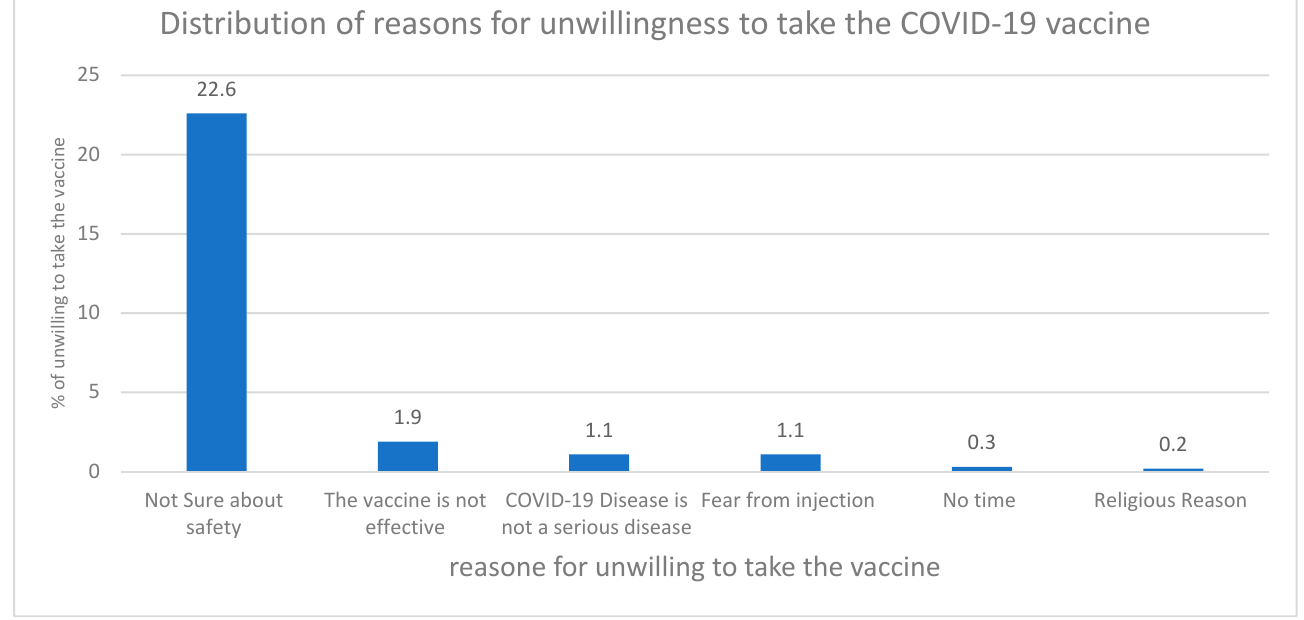
Figure 1. Distribution of reasons for unwillingness to take the COVID-19 vaccine. The multivariable analysis performed to investigate the significant factors of univariate analysis, after adjustment for sex, region, nationality, level of education, working state, and similar to the univariate. Table 4. Factors associated with an increased willingness to take the COVID-19 vaccine among the public in Oman (N =